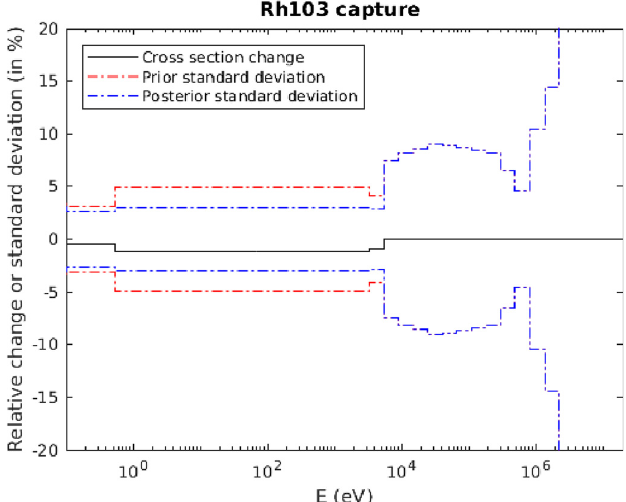
Fig. 7. Multigroup trends and associated uncertainties, by the assimilation of the MAESTRO + ERMINE experiments together.